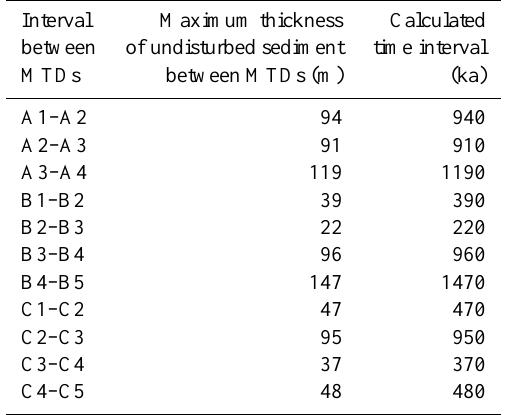
Table 2. Calculated minimum time intervals between slide events, based on constant sedimentation rates of 10cmka − 1 (from Rodolfo,